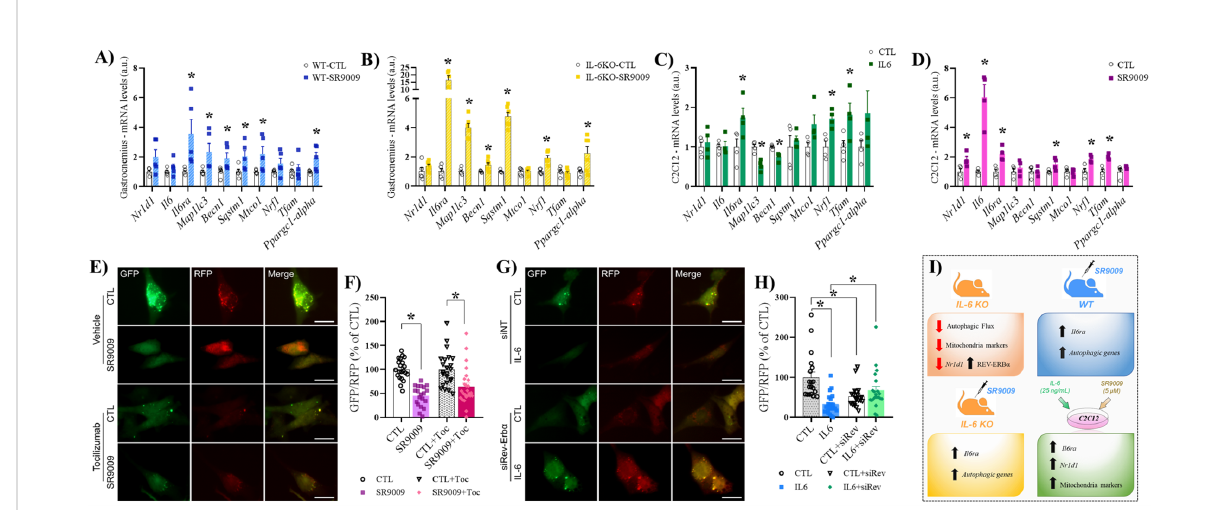
FIGURE 5 mRNA levels after IL-6 or SR9009 treatment. SR9009 treatment in WT mice (gastrocnemius) (A) ; SR9009 treatment in IL-6 KO mice (gastrocnemius) (B) ; IL-6 treatment in C2C12 (C) ; SR9009 treatment in C2C12 (D) ; Representative images of GFP/RFP in C2C12 (E, G) ; GFP/RFP (SR9009 and Toc) (F) ; GFP/RFP (siREV) (H) . Summary of key data (I) . Data correspond to the mean ± SEM of n=5-6 for experiments mice/group. *p ≤ 0.05 vs. CTL; Control (CTL), IL-6 (IL-6; received IL-6 treatment), and SR9009 (SR9009; received SR9009 treatment). a.u., arbitrary units; IL- 6 KO, interleukin 6 knockout; WT, wild-type; Toc,